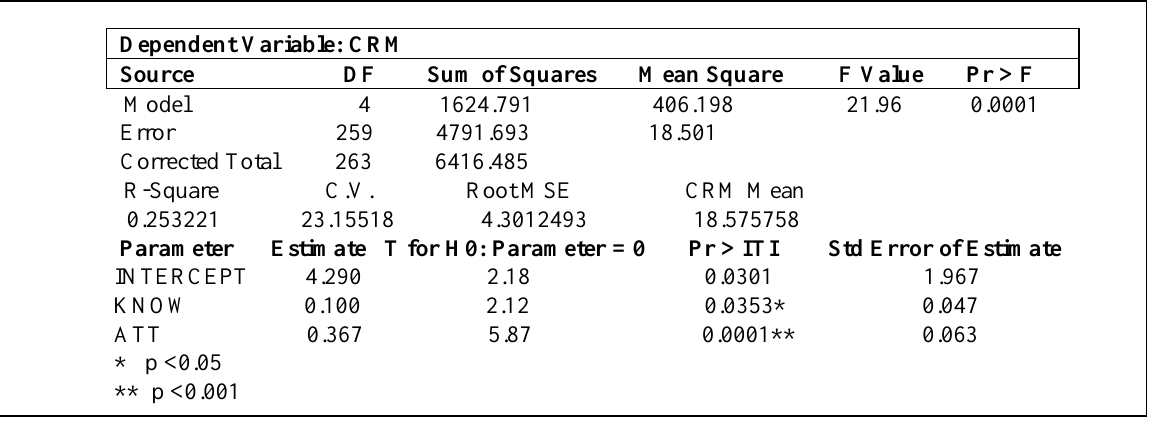
Table 2: Multiple regression analysis: influence of independent variables on CRM